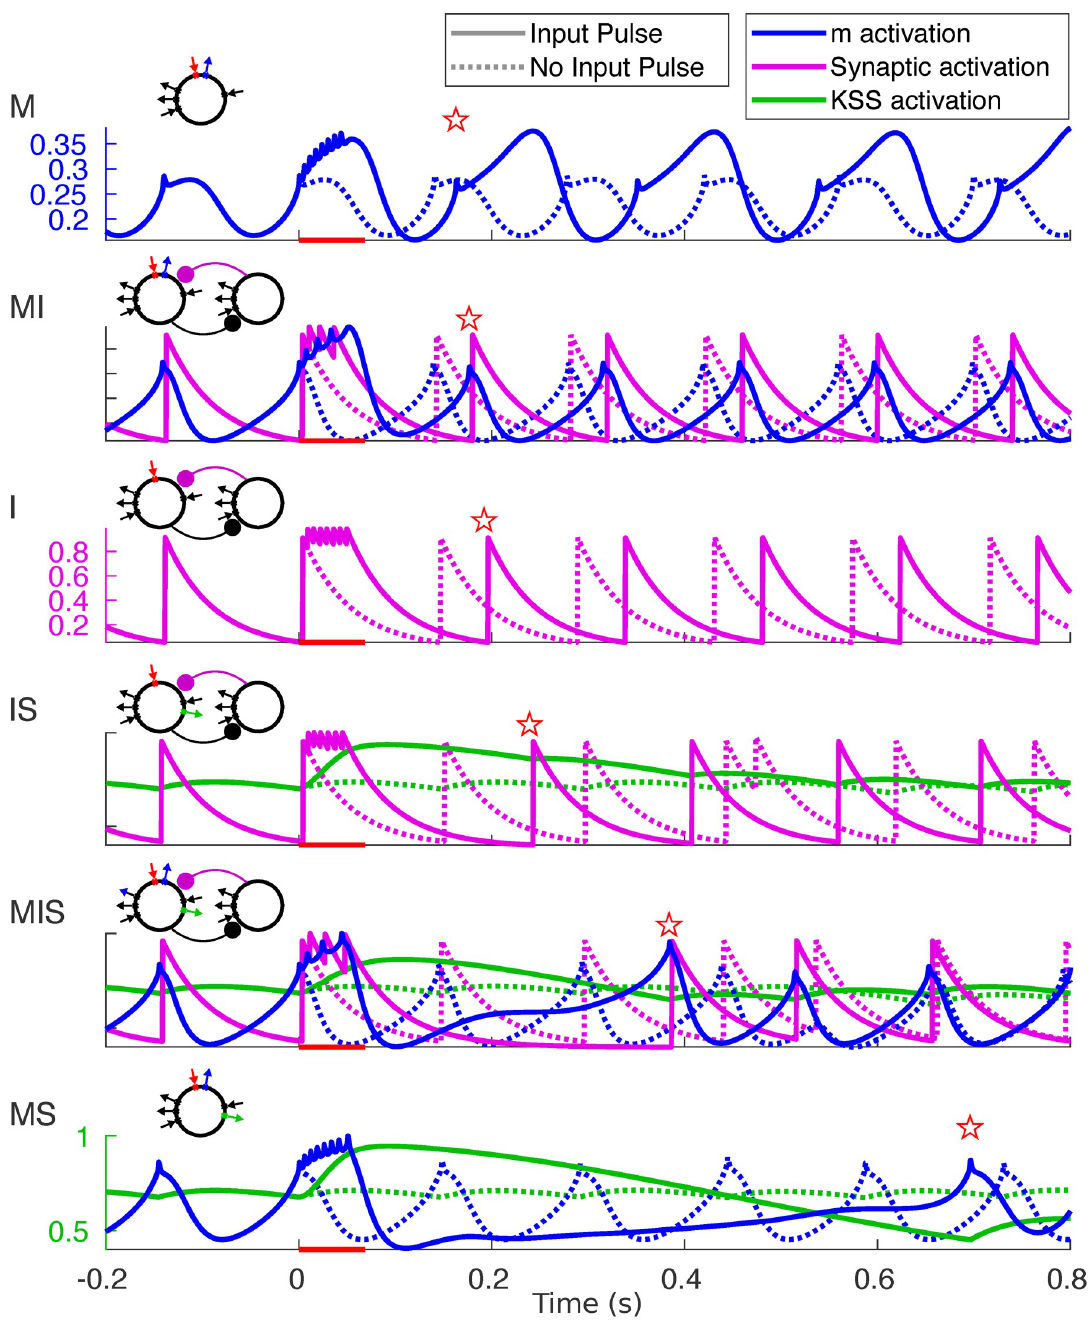
Fig 8. Buildup of outward currents in response to input pulses. Activation variables (color) plotted for simulations both with (dotted lines) and without (solid lines) an input pulse lasting 50 ms. Red bar indicates the timing of the input pulse; red star indicates the time of the first post-input